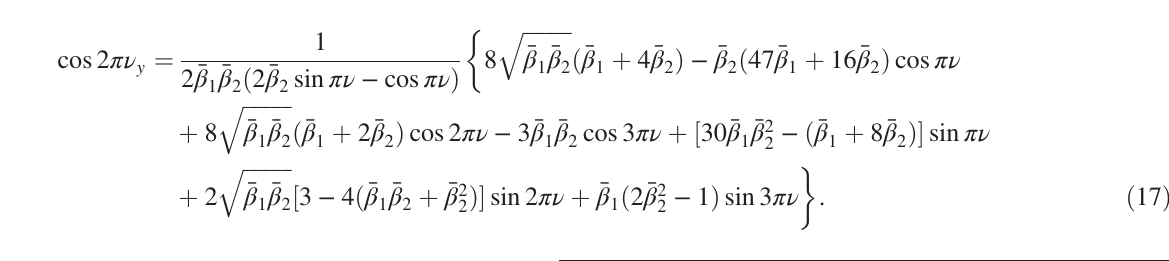
FIG. 7. The horizontal beta functions at the end (left) and center (right) of the cell as a function of the betatron tunes with various ∶ ν 1 ∶ 4 ; 1 ∶ 3 , and 1 ∶ 2 represented by blue, red, and black color ratios: ν y x ¼